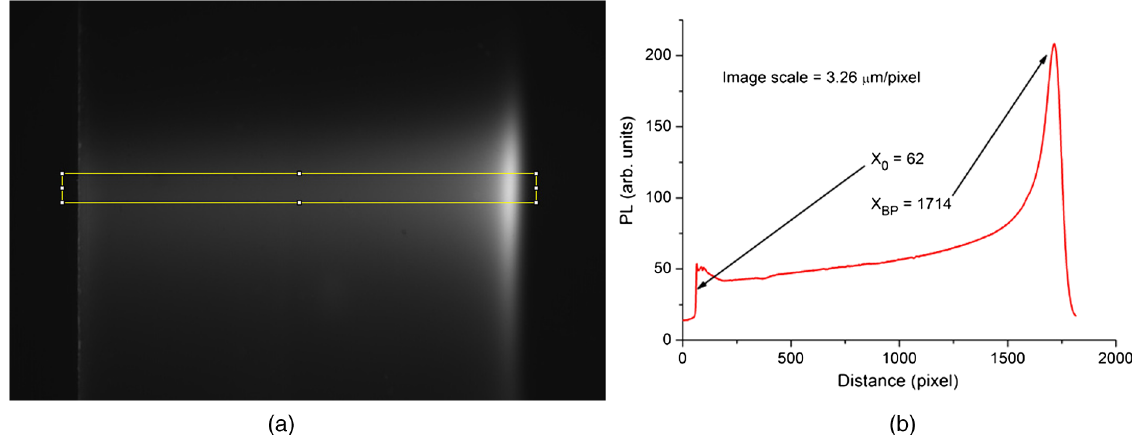
FIG. 19. (a) Bragg curve PL image stored in the LiF crystal placed at the exit of SCDTL-4 and (b) PL intensity profile versus depth in the selected yellow rectangular